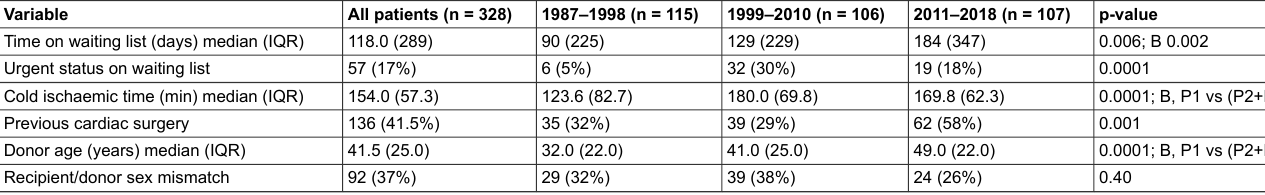
Table 3: Risk factors for heart transplantation surgery.